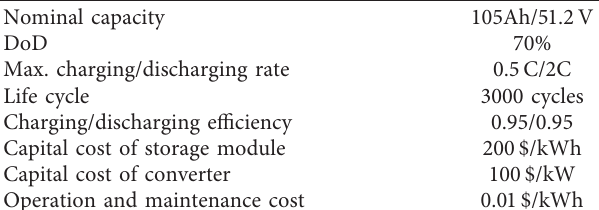
Table 2: Parameters of a storage